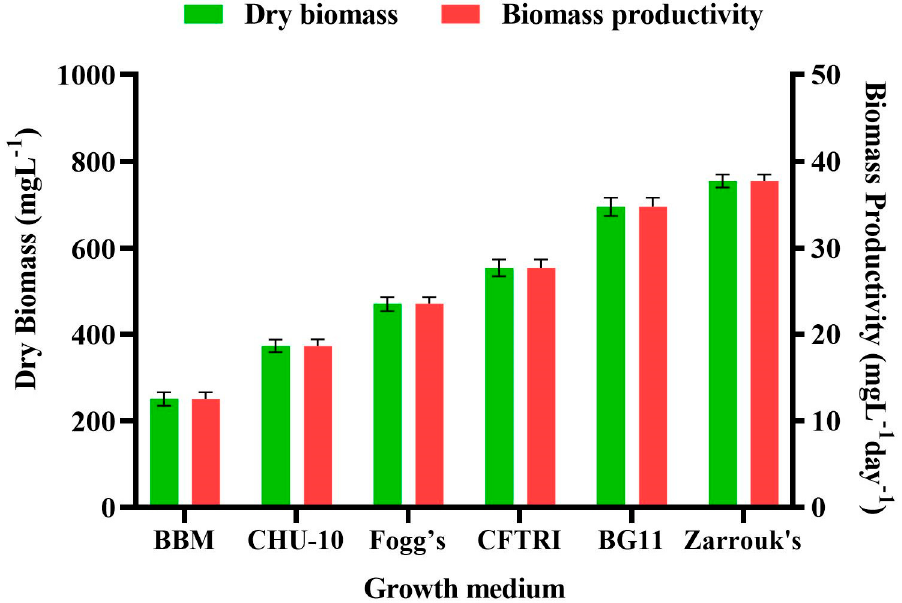
Figure 4. Estimation of dry cell weight and biomass productivity of S. rotundus MG910488 after cultivation in various medium.